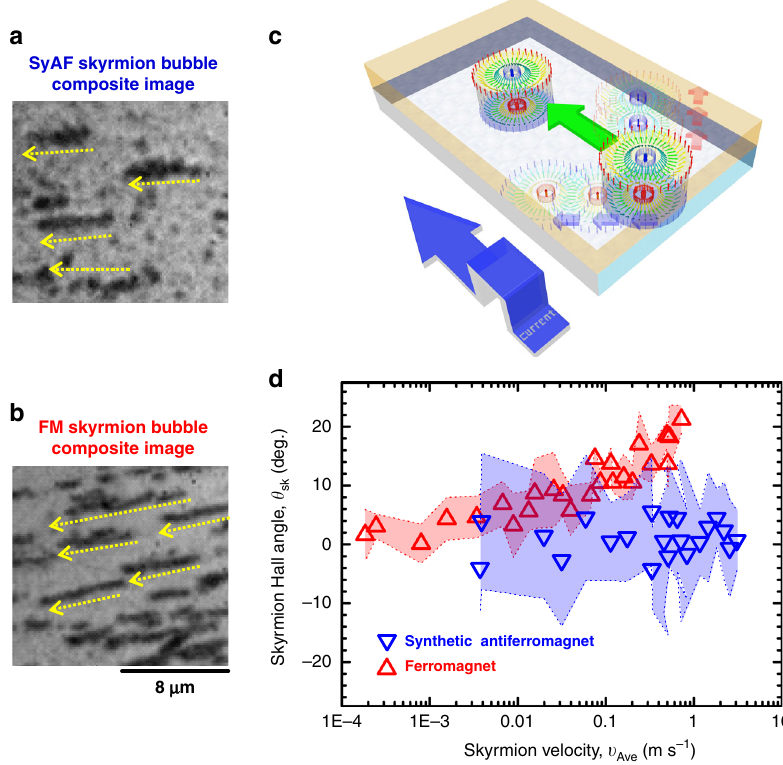
Fig. 3 Skyrmion Hall effect in synthetic antiferromagnetic skyrmion bubbles vs ferromagnetic skyrmion bubbles. a The composite image of current-induced motion of SyAF skyrmion bubbles for three-pulses injection with the pulse width 1 μ s. b The composite image of ferromagnetic skyrmion bubbles for three 5- μ s-long pulses. Yellow arrows represent direction of displacement of skyrmion bubbles. c Schematic of the current-induced SyAF skyrmion motion in our experiment. d Skyrmion Hall angle as a function of average skyrmion velocity for synthetic antiferromagnetic (blue) and ferromagnetic (red) skyrmion bubbles. Colored range represents standard